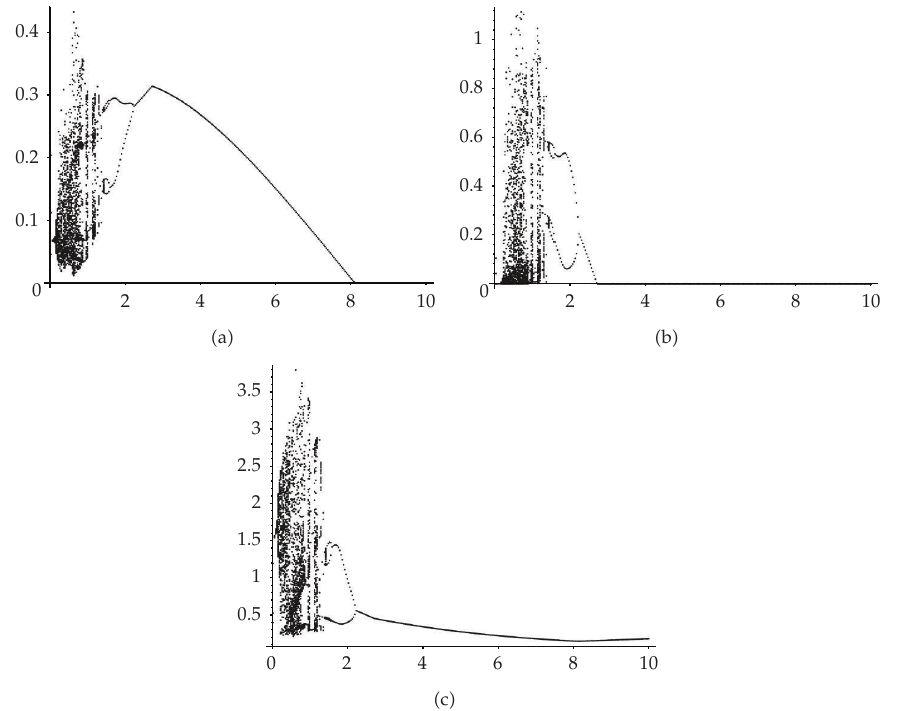
Figure 2: Bifurcation diagrams for system (cid:5) 1.1 (cid:6) showing the e ff ect of p . (cid:5) a (cid:6) x versus p , (cid:5) b (cid:6) y versus p , and (cid:5) c (cid:6) z versus p